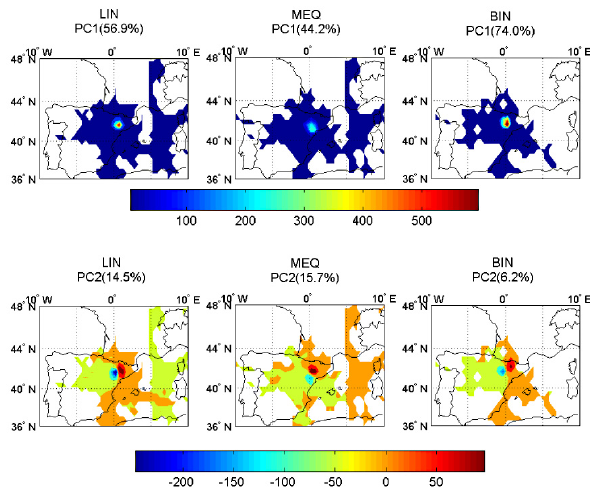
Fig. 3. Maps resulting from Principal Component Analysis (PCA) applied to an original matrix composed by the residence time in the RPSI grid cells (observations) for 51 backward simulations for 2006 (variables) for each of the three sites belonging to the Liny- ola’s CAS. The classification of the RPSI grid cells as a function of the new variables (PC1 and PC2) is shown, expressed in min- utes. Negative values in PC2 values indicate that a number of RPSI grid cells are incompatible with others. A classification of the RPSI grid cells is obtained from PCA: local versus regional (identified by PC1); and regional ones depending on the weather pattern (identi- fied by PC2).